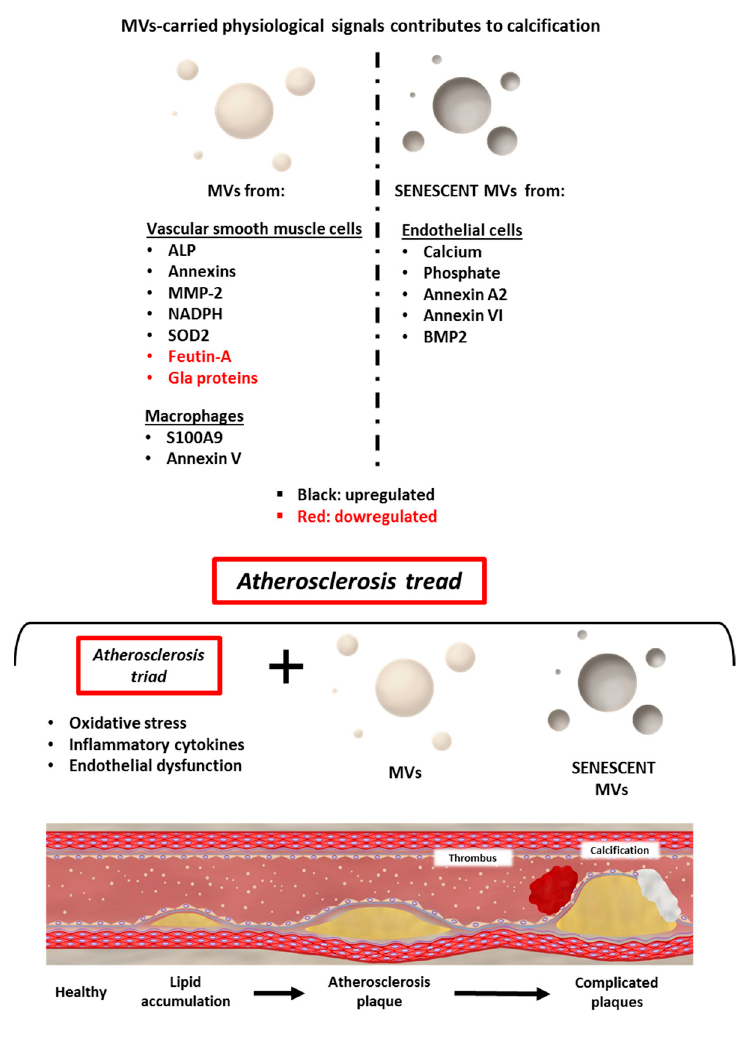
Figure 3. MVs in atherosclerotic calcification.